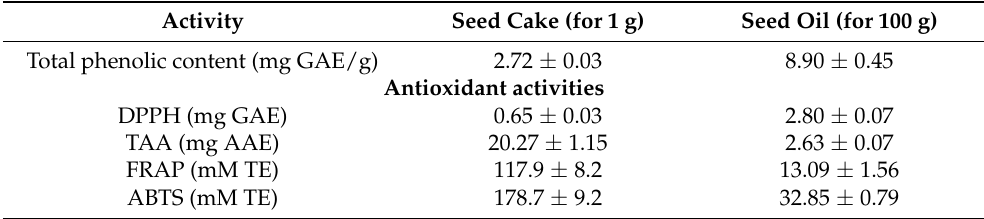
Table 6. Total phenolic content and antioxidant activities of seed cake and seed oil of Balanites roxburghii . Activity Seed Cake (for 1 g) Seed Oil (for 100 g) Total phenolic content (mg